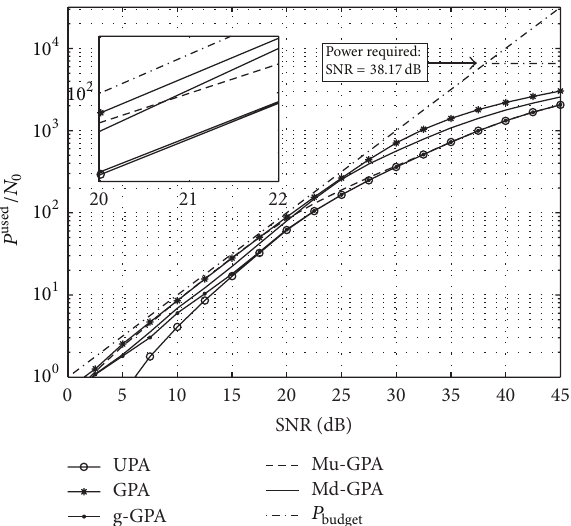
Figure5:Powerusedbytheconsideredalgorithmsfora 4×4 MIMO system to achieve their respective throughput in Figure 4.